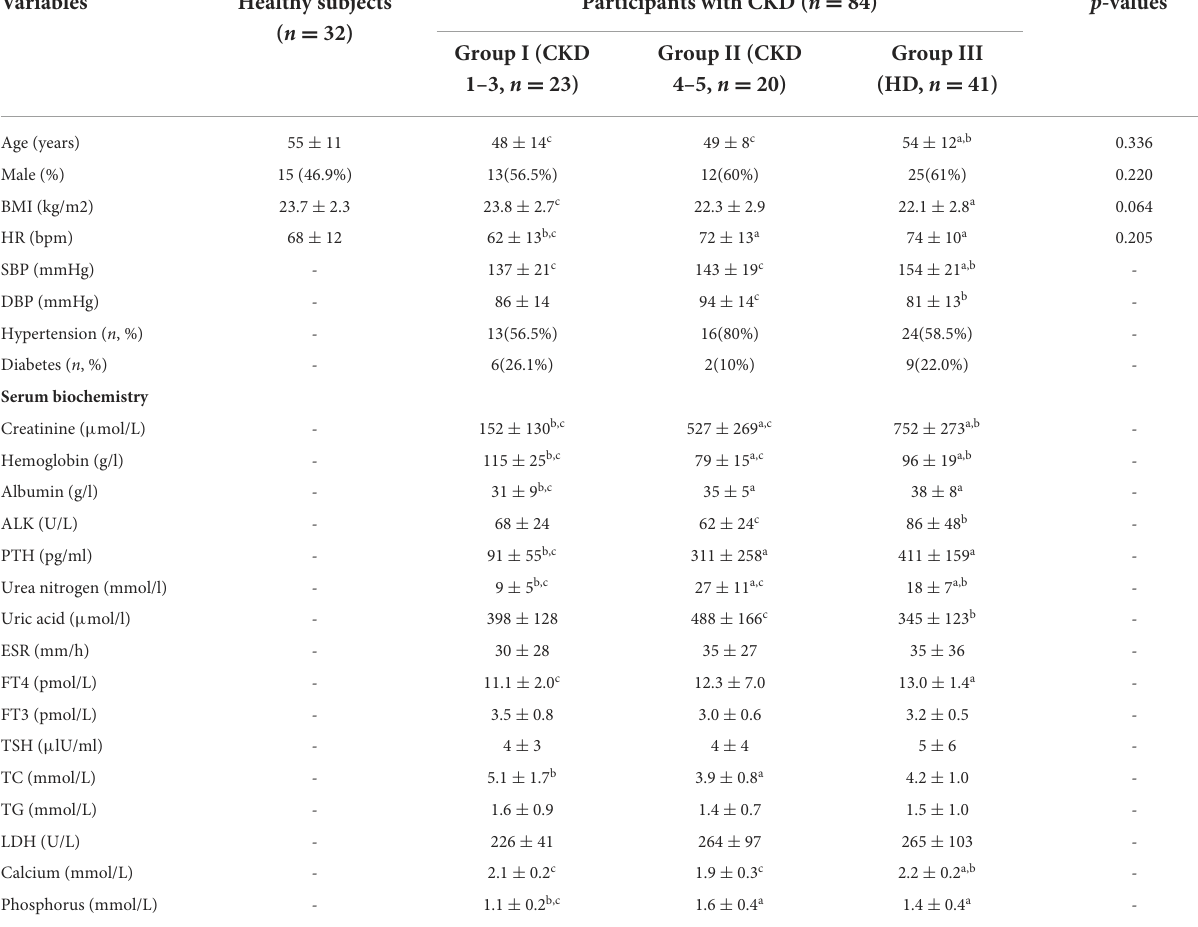
TABLE 1 Clinicopathologic characteristics of the study